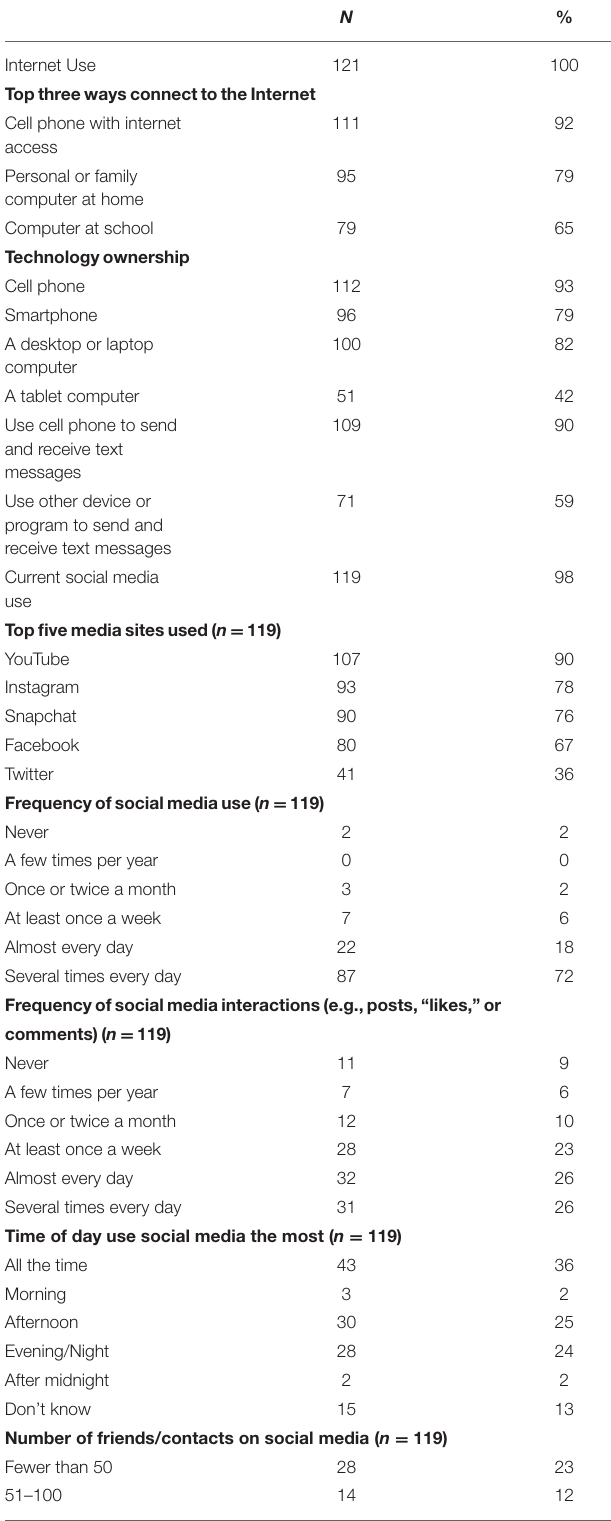
TABLE 1 | Use of digital technology by adolescents receiving mental health